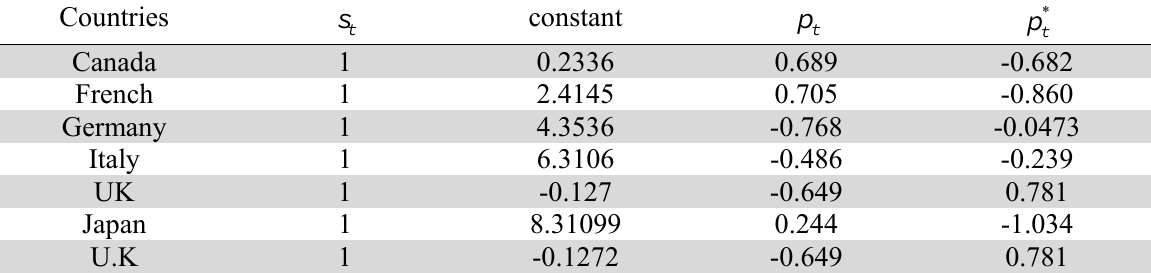
Engle and Granger cointegration results for the